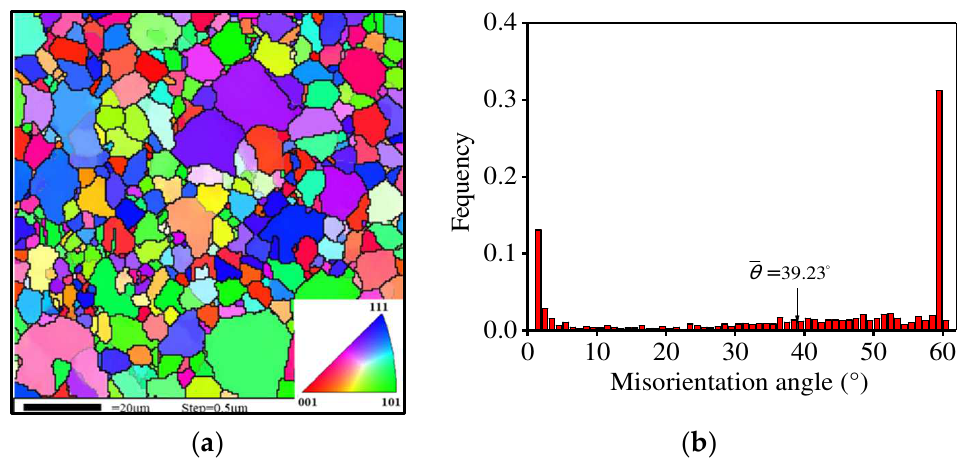
Figure 1. Initial microstructure of the HIPed superalloy: ( a ) EBSD-OIM map; ( b ) Misorientation angle distributions.